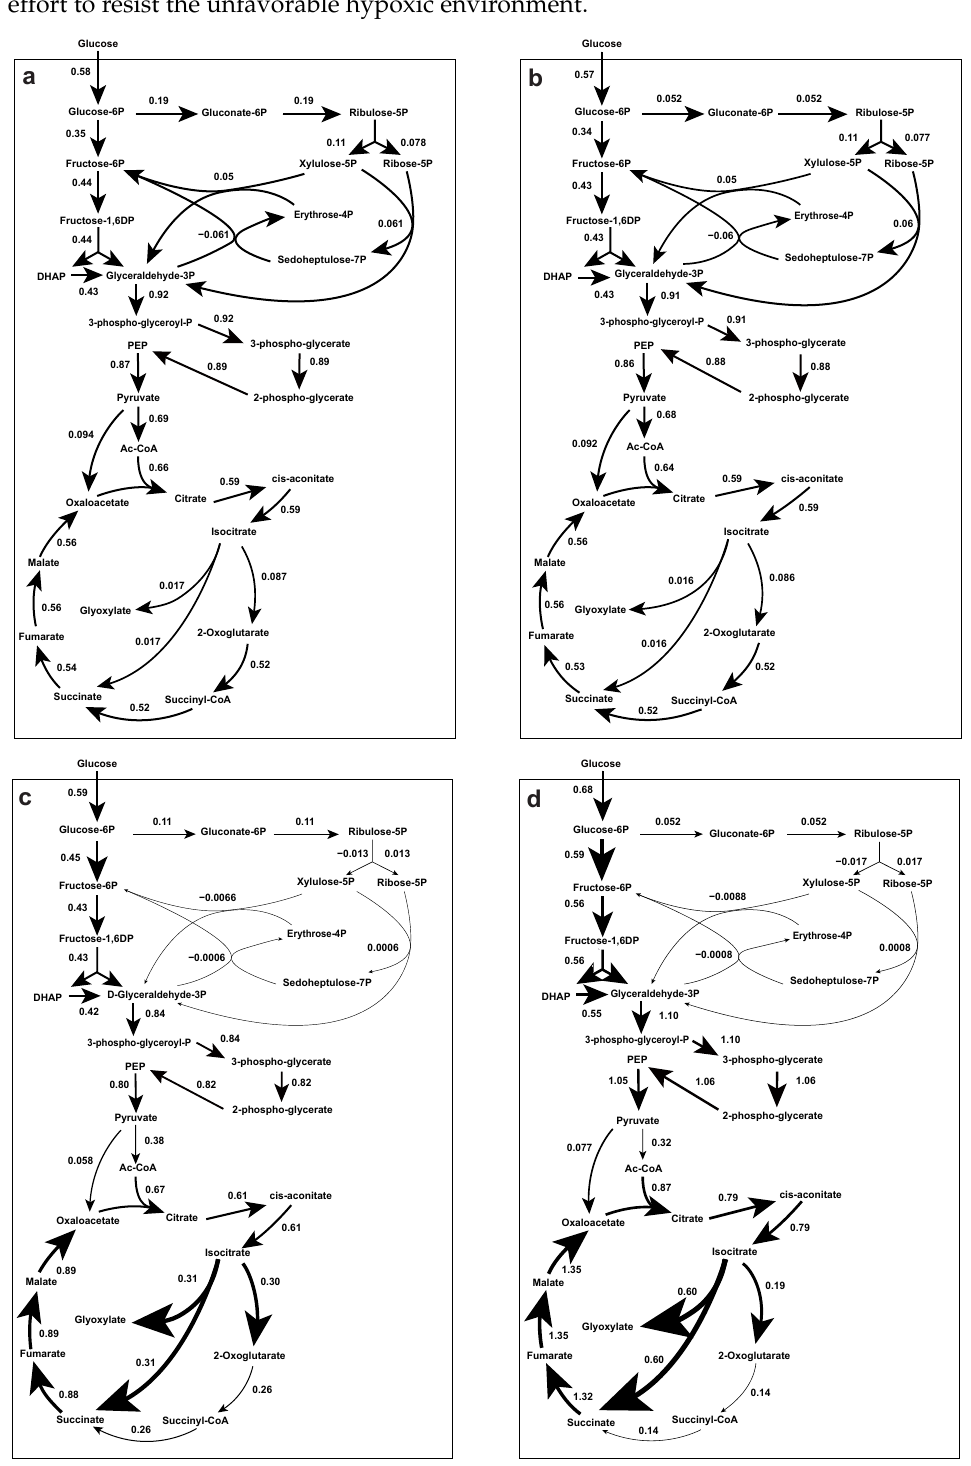
Figure 9. Fluxes (mmol/gDW/h) of P. chrysogenum Wisconsin 54-1255 through the central metabolic pathway calculated with the genome-scale metabolic model (IAL1006) using the RAVEN toolbox. ( a ) 60% dissolved oxygen, ( b ) 20% dissolved oxygen, ( c ) 10% dissolved oxygen and ( d ) 5% dissolved oxygen. The specific rates calculated in Table 1 are used as model inputs, with maximization of cell growth as the objective function. The direction of the arrow indicates the direction of the flux and